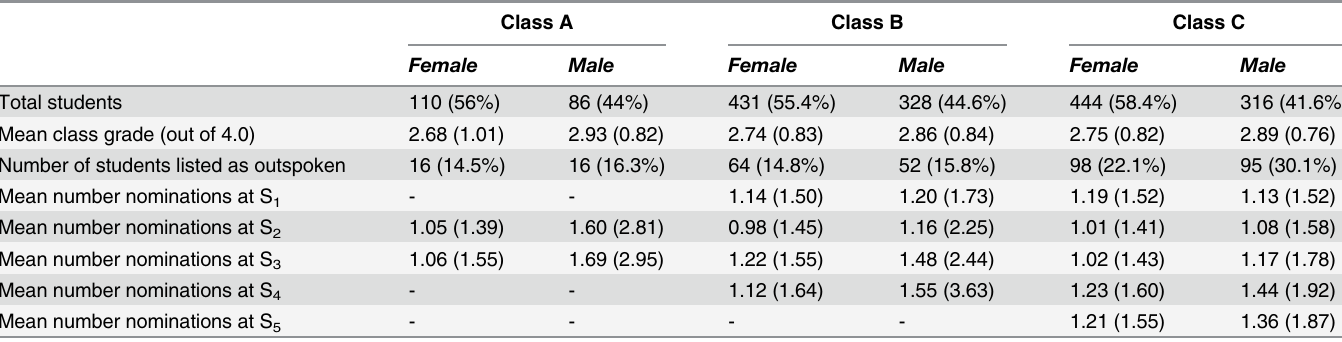
Table 1. Student demographics from all three classes. Classes are majority female in all three cases. Males performed slightly better than females in each class, and also tended to be more outspoken. Numerical counts are accompanied by total percentage in the class in parentheses. Means are accompa- nied by standard deviations in